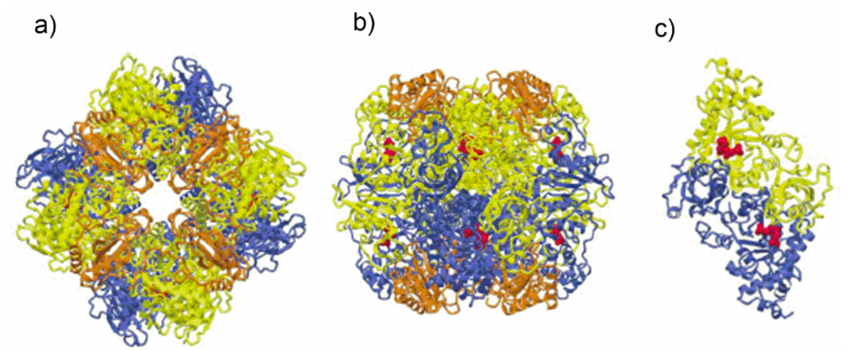
Figure 1. ( a ) Schematic drawing of Form I Rubisco from spinach showing the spatial arrangement of the L 8 S 8 hexa-decamer view along the four-fold axis. The L subunits appearing in the figure are represented in yellow and blue. The figure also evidences the S subunits (represented in orange) delimiting the solvent channel; ( b ) schematic drawing of the Rubisco from spinach, view along one of the two-fold axes; ( c ) Form II Rubisco from Rhodospirillum rubrum showing the two-fold symmetry of the L2 dimer. The substrate mimic 2-carboxy-D-arabinitol 1,5-bisphosphate (2CABP), displayed as red spheres (Figure from ref. [19], adapted and used by permission of Elsevier (copyright ©